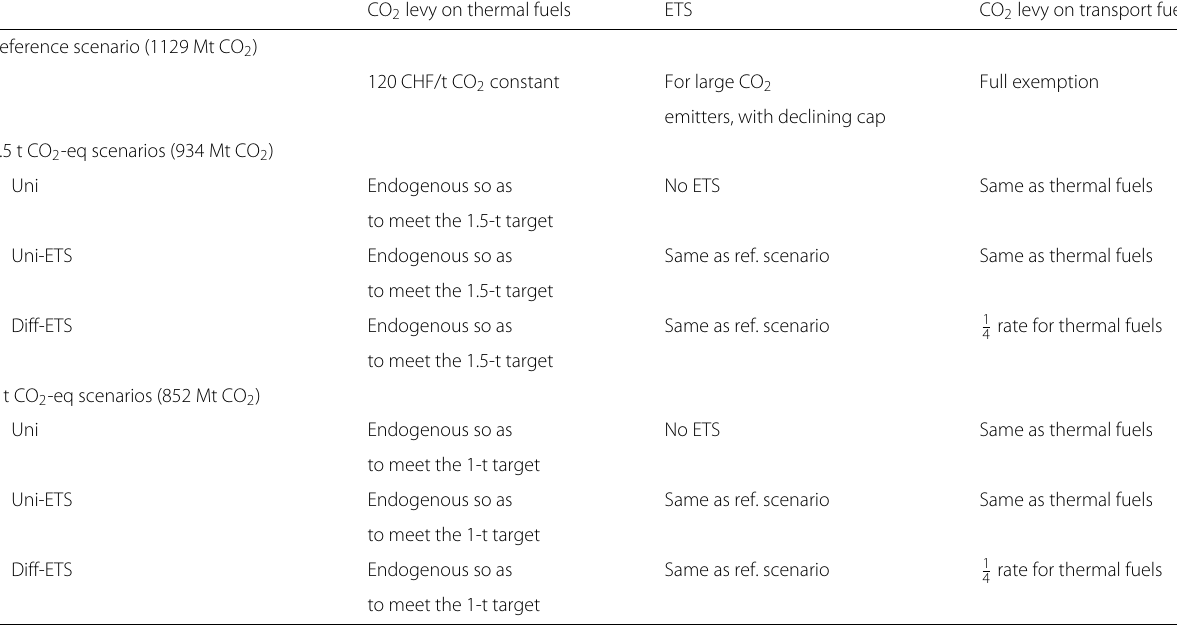
Table 2 Policy instruments in the simulated scenarios and Swiss carbon budget in Mt CO 2 CO 2 levy on thermal fuels ETS CO 2 levy on transport fuels Reference scenario (1129 Mt CO 2 )